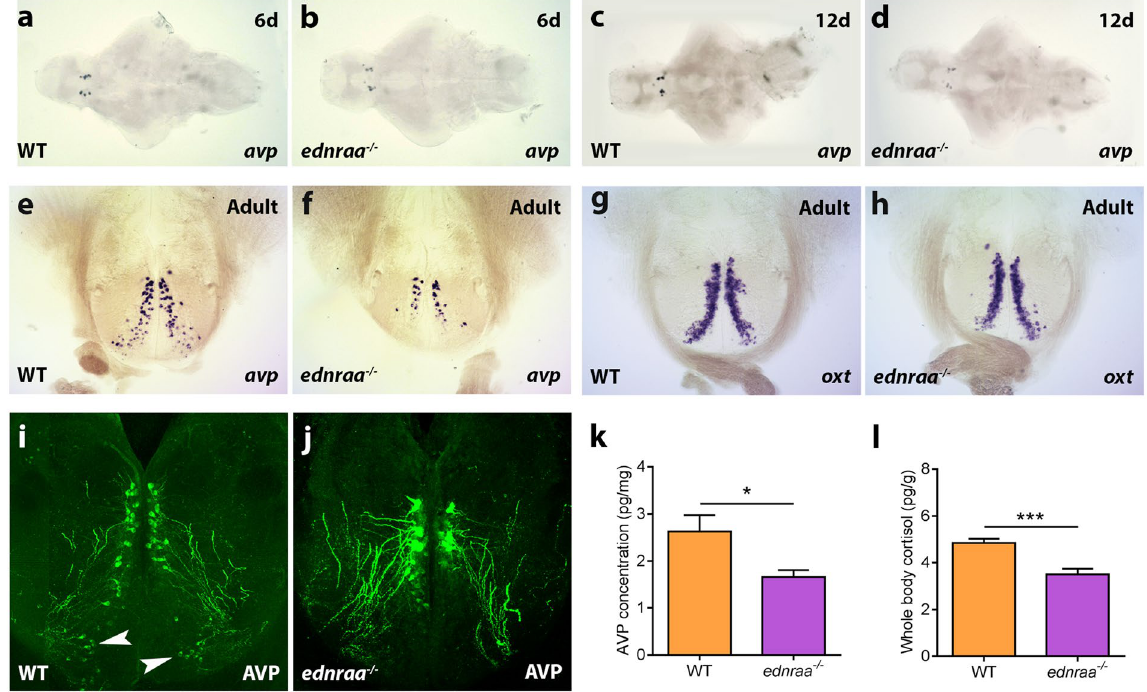
Figure 6. Altered distribution of arginine vasopressin neurons in ednraa − / − . In situ hybridisation showing that expression of arginine vasopressin ( avp ) is similar in the brain of WT ( a , c , e ) and ednraa − / − ( b , d , f ) at 6 days (a , b) and 12 days (c , d) . (e , f) Reduced expression of avp in the ventral parvocellular preoptic area of ednraa − / − of adult fish. (g , h) In situ hybridisation showing that oxytocin ( oxt ) expression is similar in WT and ednraa − / − adult fish. (i , j) Anti-AVP antibody staining shows reduced labelling in the parvocellular preoptic area of ednraa − / − ( j ) compared to WT ( i ) (arrowheads). Dorsal magnocellular neurons have a larger cell body and thicker projections. (k) Reduced levels of AVP in the brain of ednraa − / − compared to WT. (l) Decreased whole- body cortisol levels in ednraa − / − compared to WT. * p < 0.05, *** p <